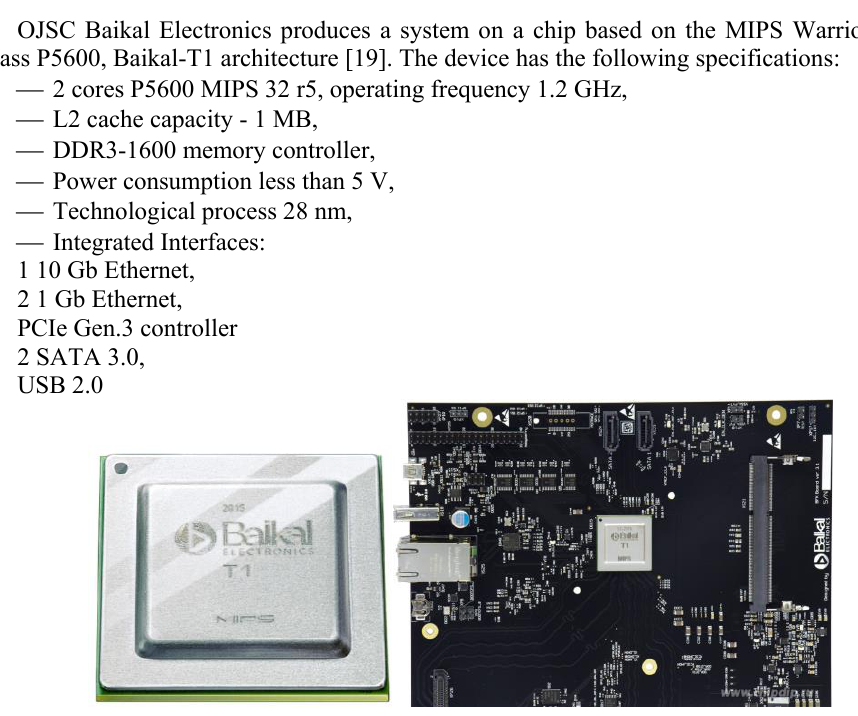
Fig. 5. Baikal-T1 SoC and Baikal-T1 processor-based computer